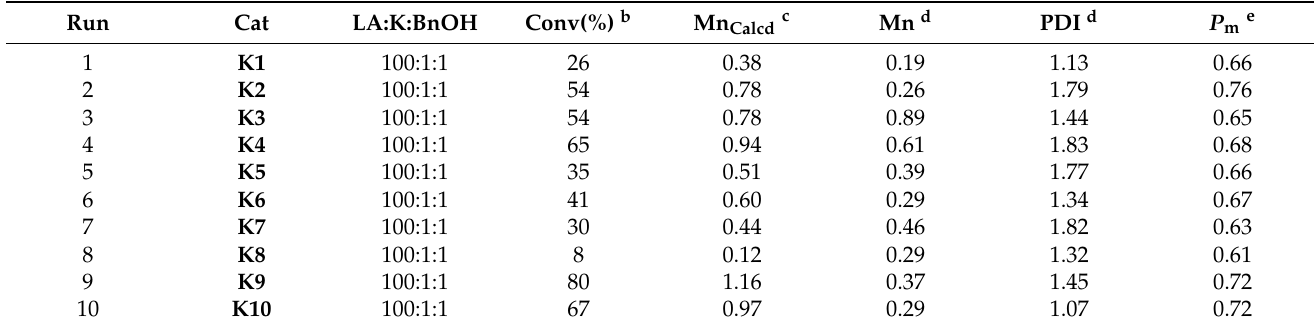
Table 4. Ring-opening polymerization of rac -lactide a .